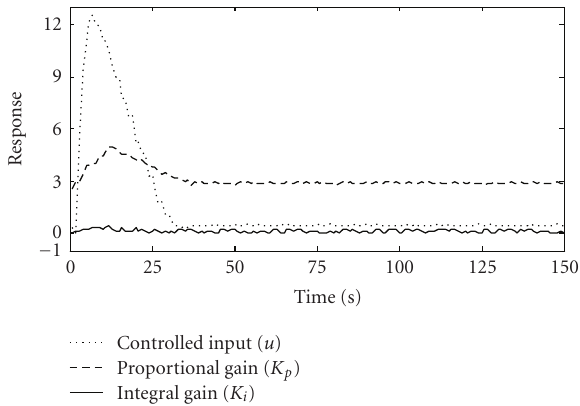
time-weighted absolute error (ITAE), and root mean